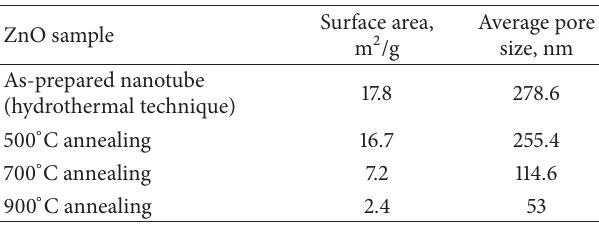
Table 1: Effect of annealing temperature on ZnO surface area and pore